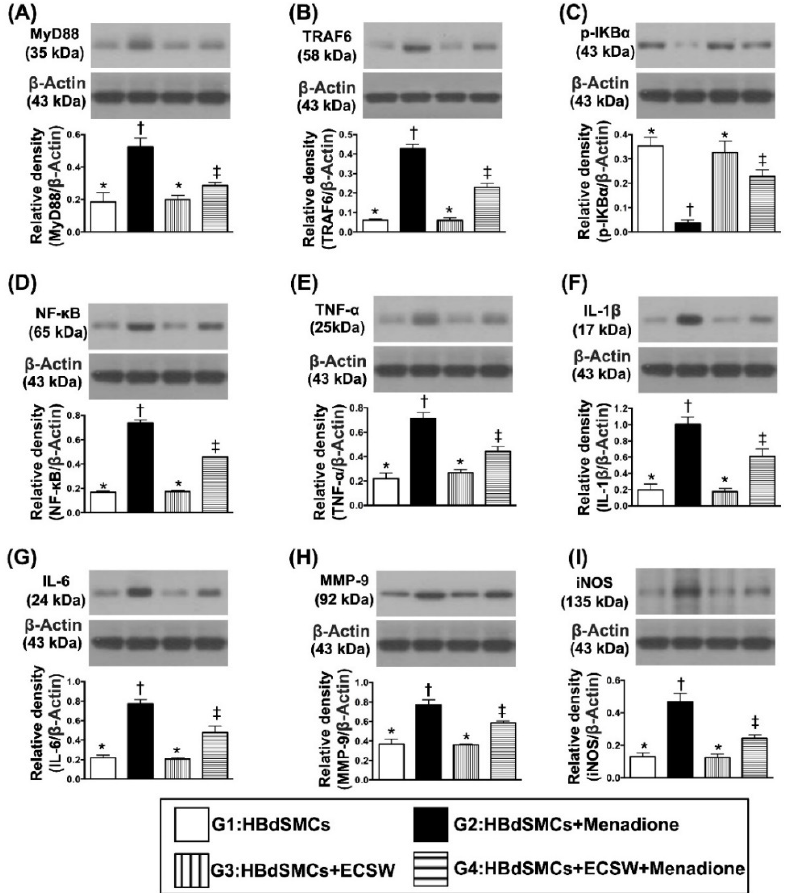
Figure 2. ECSW therapy markedly suppressed menadione-induced inflammatory reaction in RBdSMCs. ( A ) Protein expression of myeloid differentiation primary response 88 (MyD88), MyD88, * vs. other groups with different symbols (†, ‡), p < 0.001. ( B ) Protein expression of TNF receptor associated factor 6 (TRAF6), * vs. other groups with different symbols (†, ‡), p < 0.001. ( C ) Protein expression of phosphorylated (p)-IKB- α , * vs. other groups with different symbols (†, ‡), p < 0.001. ( D ) Protein expression of nuclear factor- κ B (NF- κ B), * vs. other groups with different symbols (†, ‡), p < 0.001. ( E ) Protein expression of phosphorylated tumor necrosis factor alpha (TNF- α ), * vs. other groups with different symbols (†, ‡), p < 0.001. ( F ) Protein expression of interleukin (IL)-1ß, * vs. other groups with different symbols (†, ‡), p < 0.001. ( G ) Protein expression of IL-6, * vs. other groups with di ff erent symbols (†, ‡), p < 0.001. ( H ) Protein expression of matrix metalloproteinase 9 (MMP- 9), * vs. other groups with di ff erent symbols (†, ‡), p < 0.001. ( I ) Protein expression of induced nitric oxide synthase (iNOS), * vs. other groups with di ff erent symbols (†, ‡), p < 0.001. All statistical analyses were performed by one-way ANOVA, followed by Bonferroni multiple comparison post hoc test ( n = 6 for each group). Symbols (*, †, ‡) indicate signi fi cance (at 0.05 level). ECSW = extracorporeal shock wave; RBdSMCs = rat bladder smooth muscle cells.